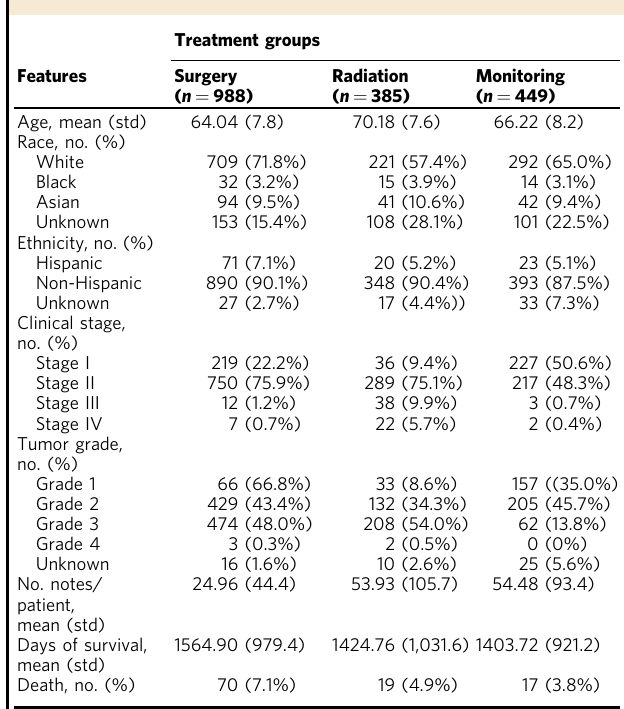
Table 1 Characteristics of the localized prostate cancer patients.